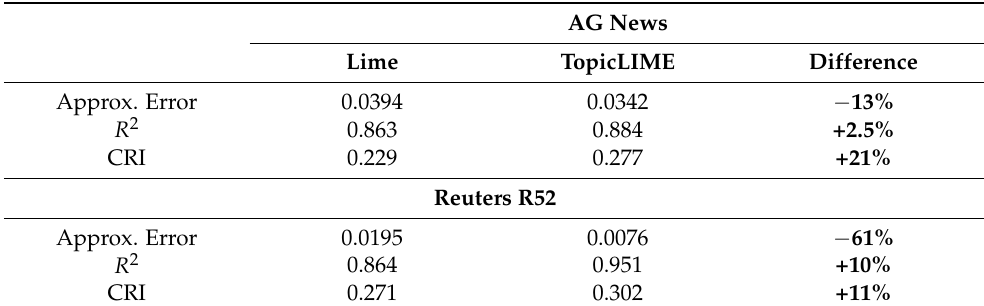
Table 2. Comparison of LIME and topicLIME with respect to local fidelity (with XGBoost as the base learner).